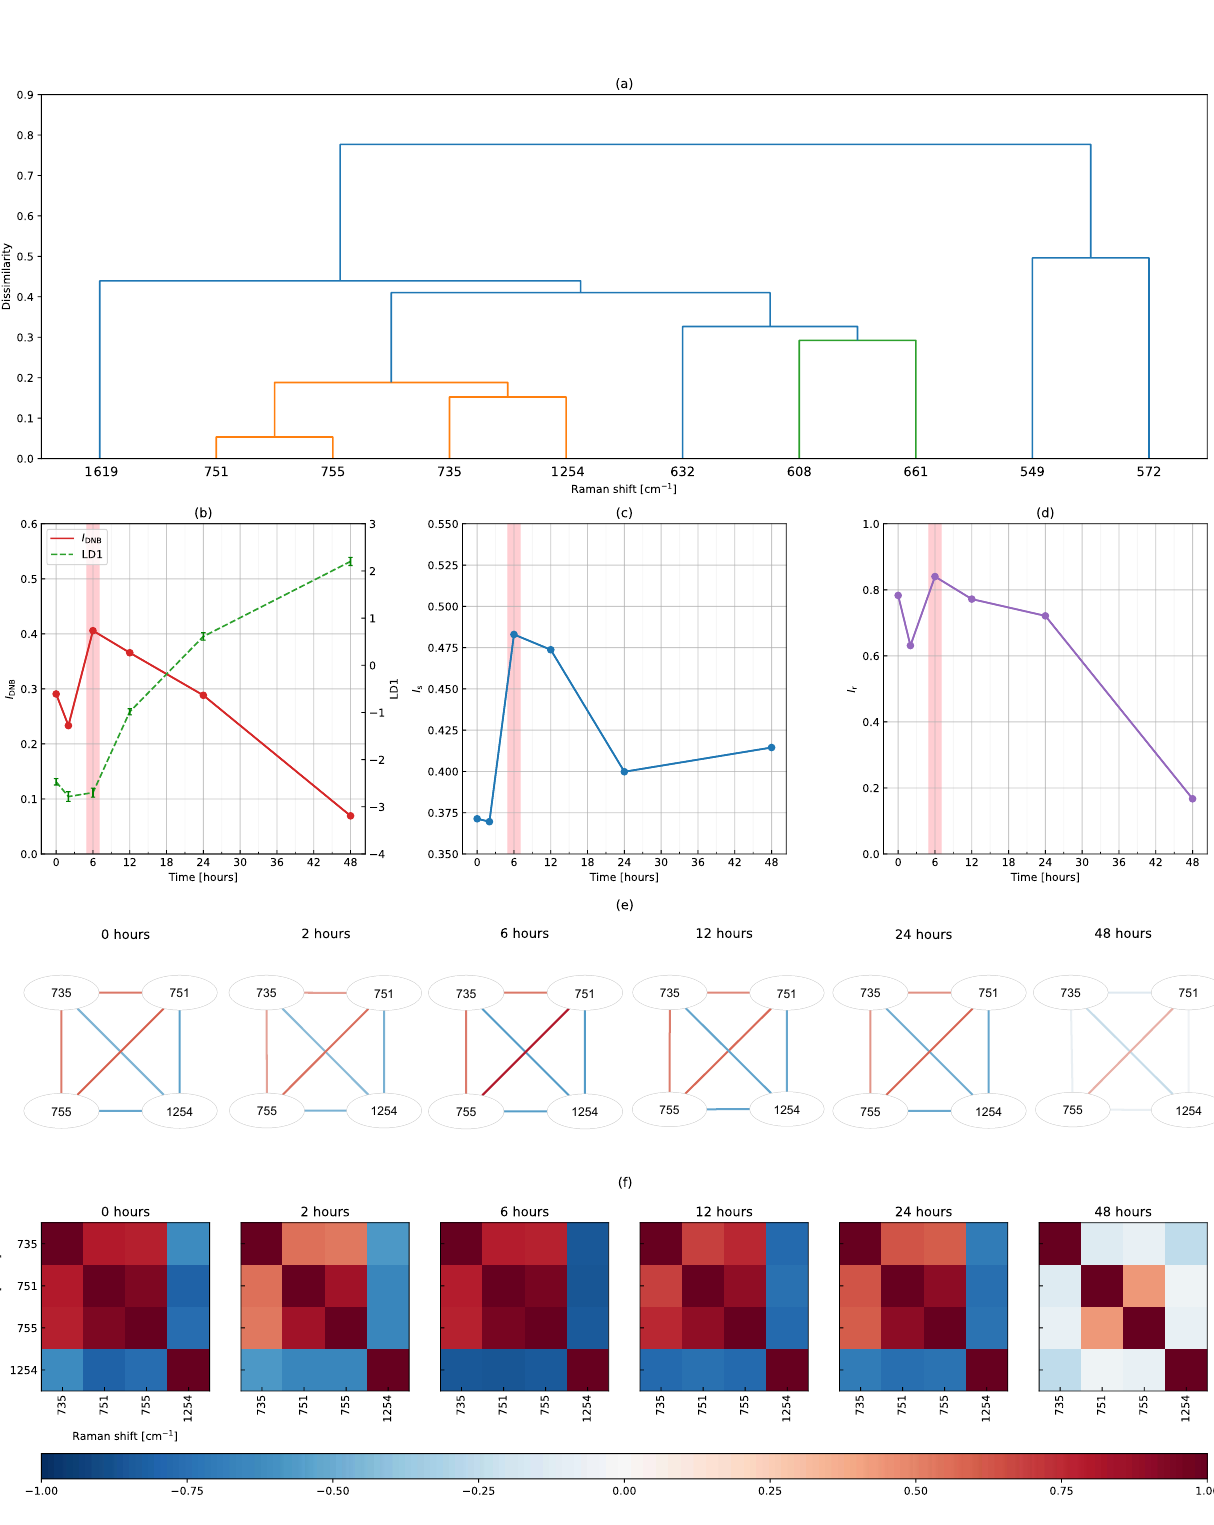
Figure 5. Results of the DNB analysis using peak-filtering Raman shifts. ( a ) A dendrogram produced by the hierarchical clustering of 10 Raman shifts fluctuating at 6 h, the time evolution of ( b ) the DNB score overplotted with the average discriminant score, ( c ) the average standard deviation and ( d ) the average correlation strength among DNB candidates, ( e ) topological structures of the weighted correlation network, and ( f ) correlation coefficients between the four DNB Raman